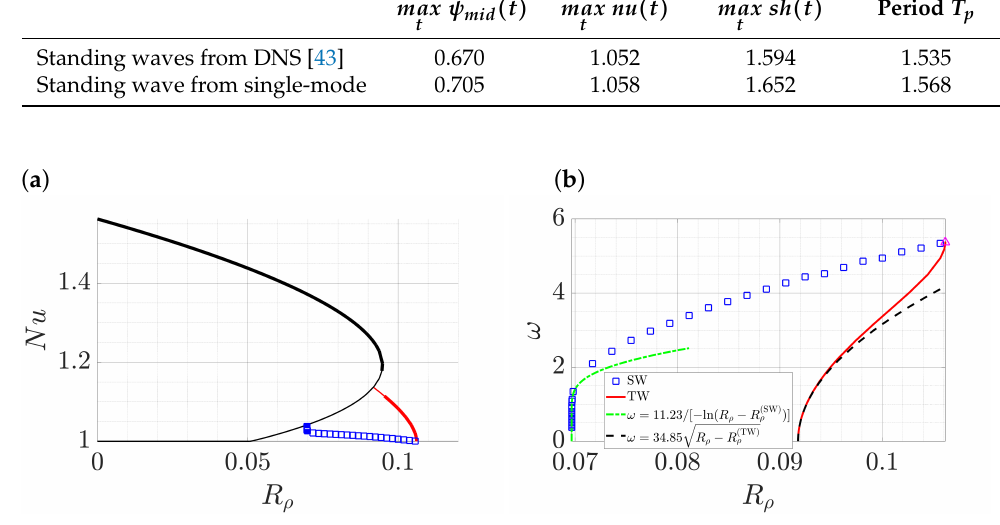
Figure 9. ( a ) Bifurcation diagram of single-mode solutions at Ra T = 53, Le = 5, k x = π and k y = 0, showing steady convection rolls ( ), SW ( (cid:3) ) and TW ( ). Thick lines indicate stable solutions and thin lines represent unstable solutions. ( b ) The temporal frequency ω = 2 π / T p of SW ( (cid:3) ) and TW ( ), the latter computed from ω = | c | k x . The Hopf frequency is ω Hopf = 5.36981 at the Hopf bifurcation point R ρ = 0.10615 ( (cid:52) ) from the trivial solution. Near the termination of the SW ( SW ) )] ( . ) as predicted branch, the frequency ω decreases to zero at R ρ ( TW ) to zero at R